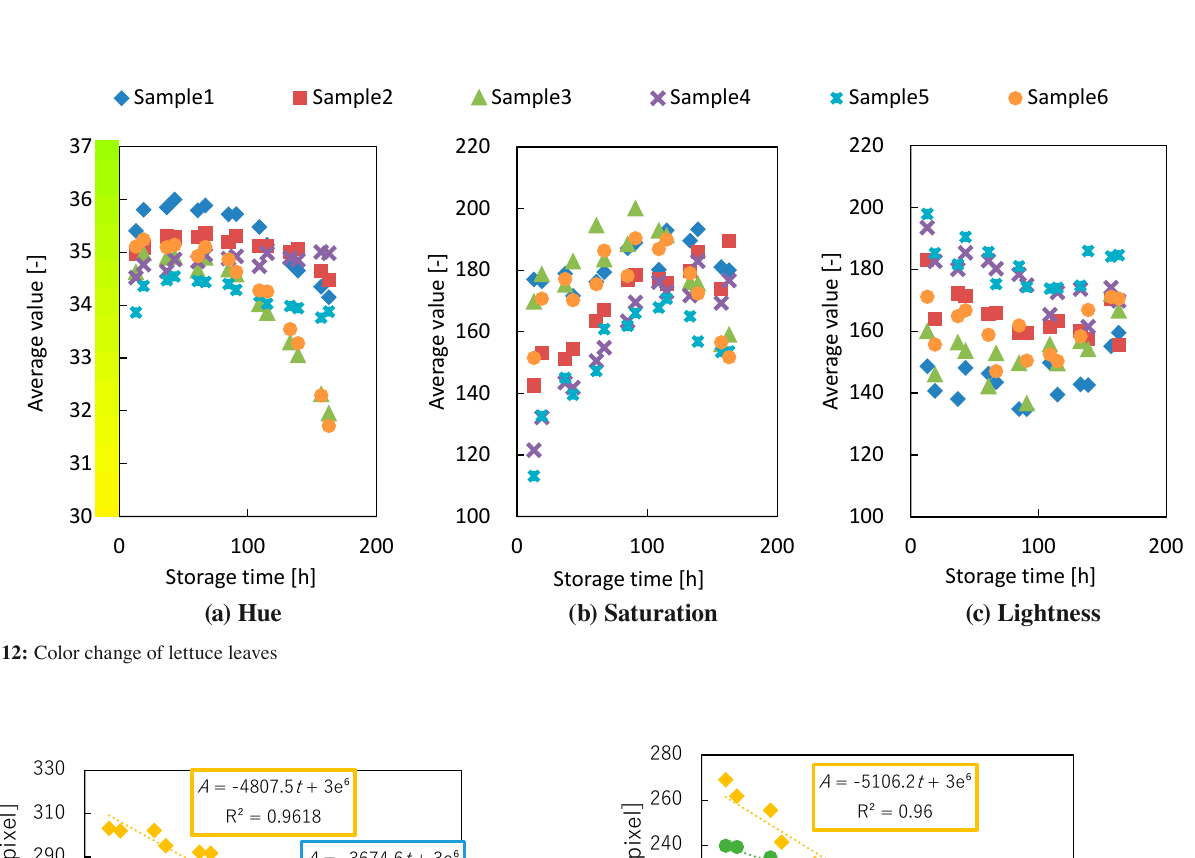
FFiigg.. 1111 TThhee cchhaarraacctteerriissttiicc ccuurrbb ooff tthhee ffrreesshhnneessss ooff lleettttuuccee.. 700 Fig. 11: The characteristic curb of the freshness of lettuce.